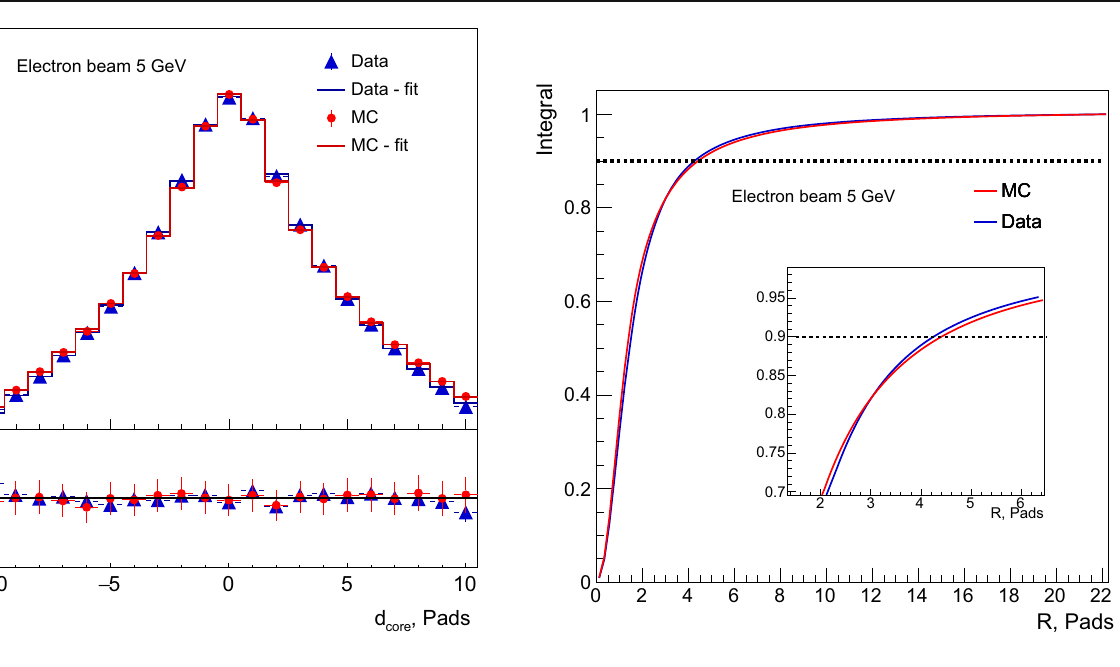
Fig. 22 The ratio of the integrals in Eq. (10) using F E ( r ) obtained from the fit, as a function of the radius R in units of the pad dimension (1.8 mm), for data (blue) and MC (red), for a 5 GeV electron beam. The insert shows an expanded view of the region 2 < R < 6 pads